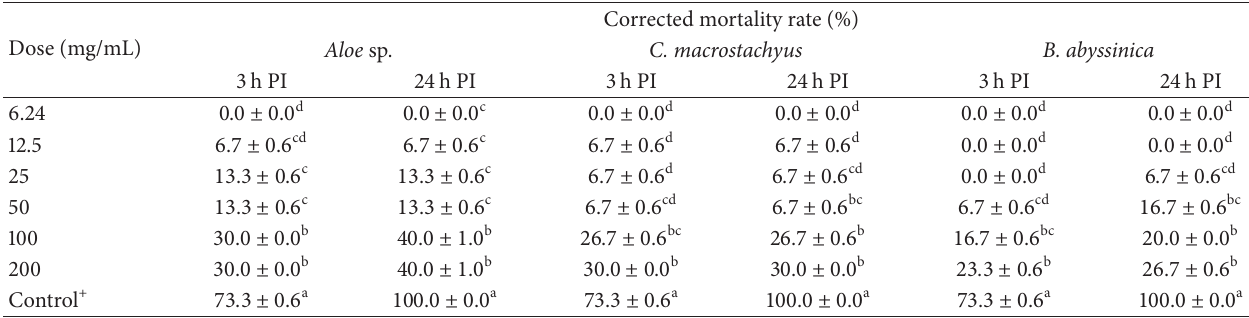
Table 4: The corrected mortality rate of M. ovinus sheep keds exposed to different concentrations of Aloe species, B. abyssinica , and C. macrostachyus leaves aqueous